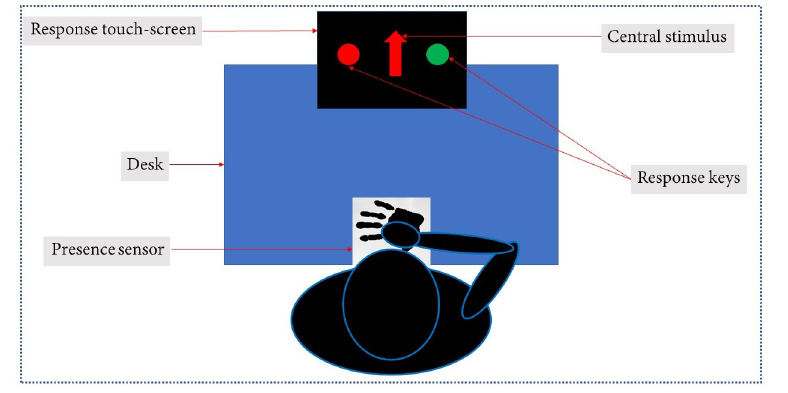
Fig 1. Experimental